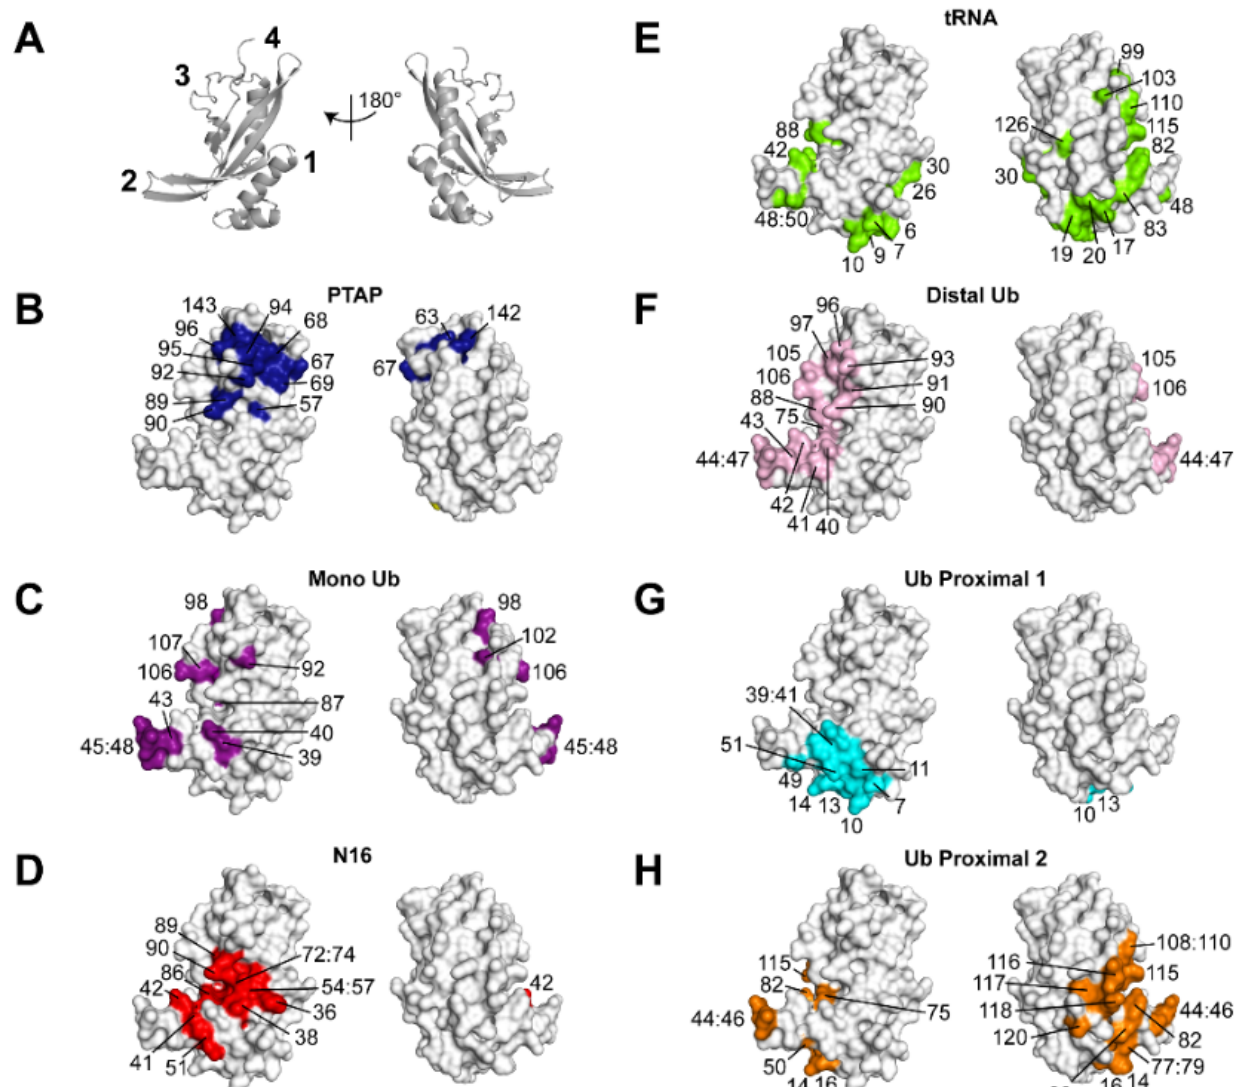
Figure 1. Binding capabilities of the Tsg101 UEV domain. Panel ( A ), UEV (gray) secondary structure elements (PDB ID: 1KPP [17]); numbers identify approximate locations of structural elements unique to the UEV domain compared to canonical E2 enzymes: 1, N-terminal α -helix-1; 2, β -hairpin; 3, vestigial active site; 4, P(T/S)AP-binding pocket. Panels ( B – H ), the same UEV structure (gray) is rendered in space-filling mode with recognition determinants of the indicated partner colored. Panels ( B – E ) highlight large chemical shift perturbations of Tsg101 measured by NMR of ( B ) a PTAP peptide, ( C ) monoubiquitin, and ( D ) N16, also known as tenatoprazole (( B – D ), [23]), ( E ) tRNA [15]. Panels ( F – H ) highlight residues identified to be in ( F ) distal, ( G ) proximal site 1 and ( H ) proximal site 2 di-Ub binding sites and used as restraints for rigid-body docking and structure